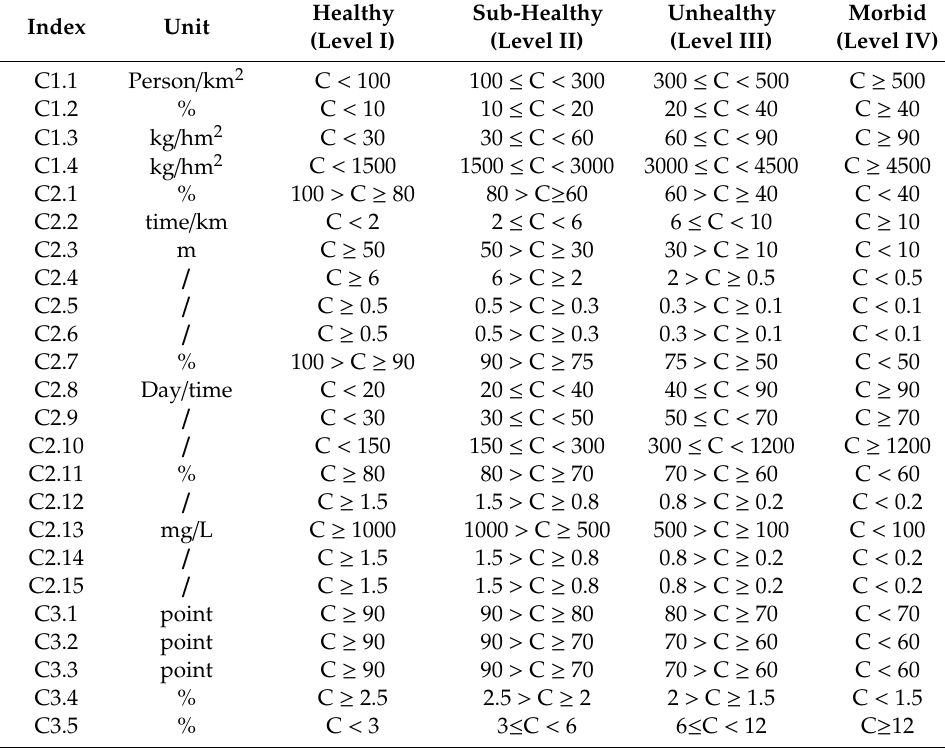
Table 3. Assessment criteria of each health